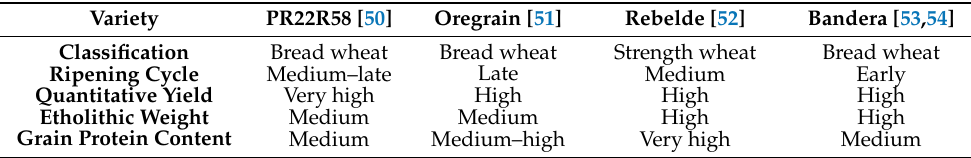
Table 2. Wheat varieties used for the experimentation and their main characteristics, as provided by the seed